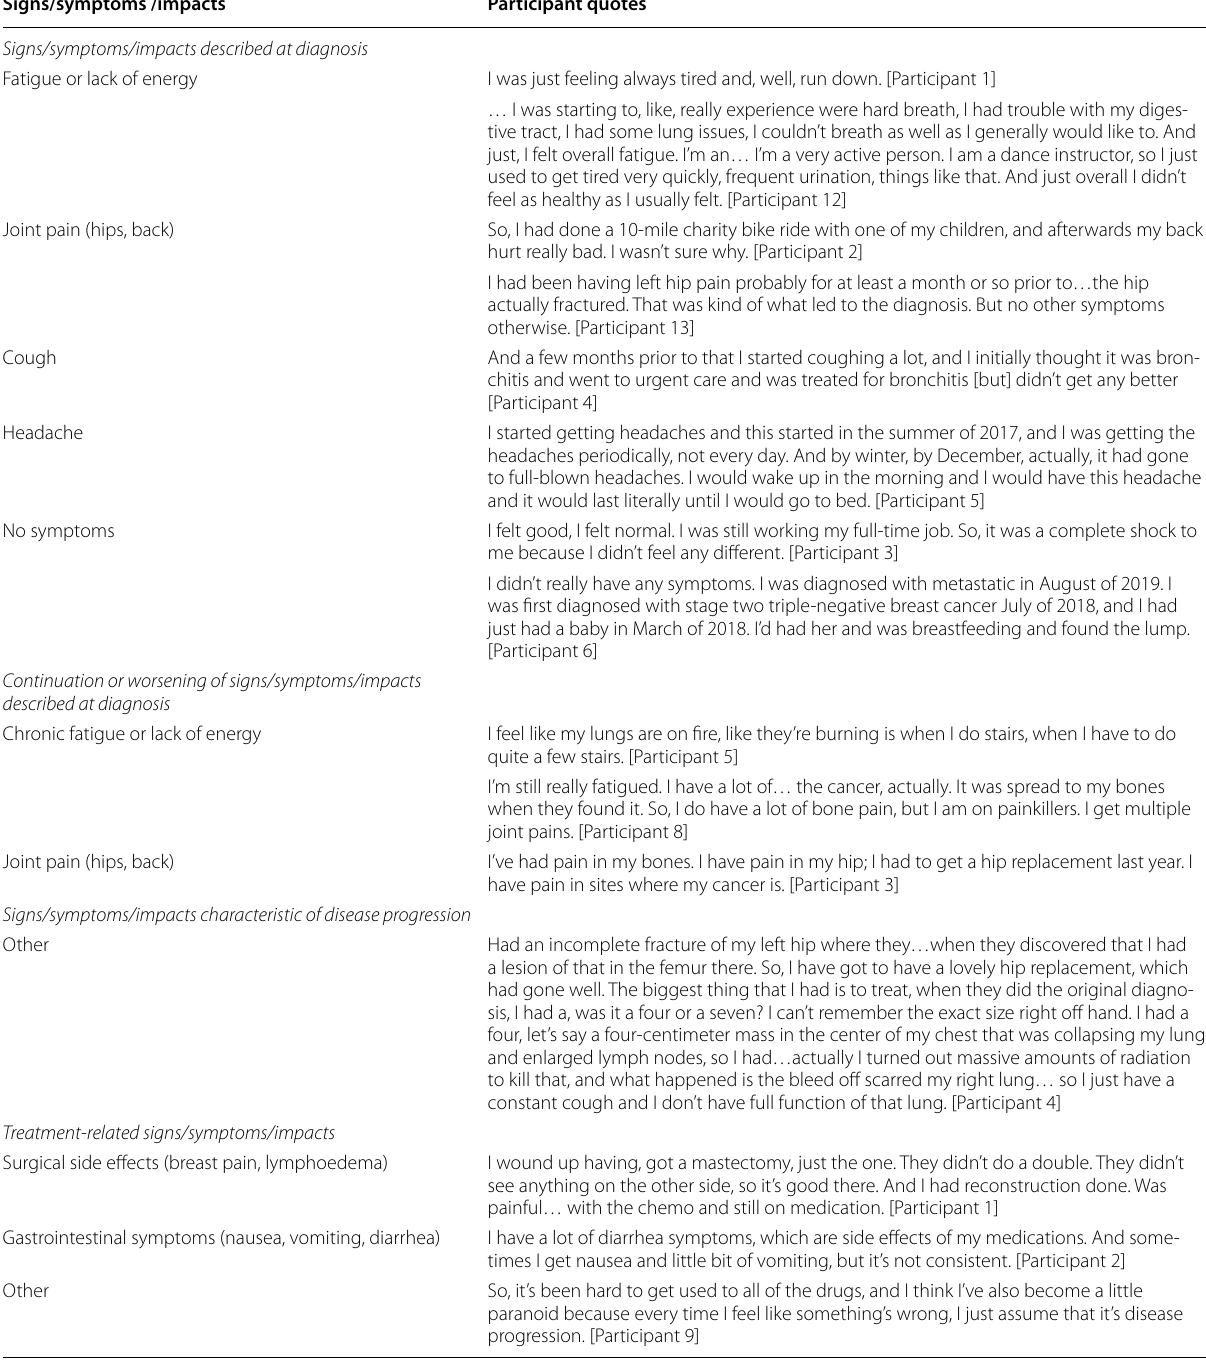
Table 2 Disease and treatment-related signs, symptoms, and impacts reported at time of diagnosis or following diagnosis Signs/symptoms /impacts Participant